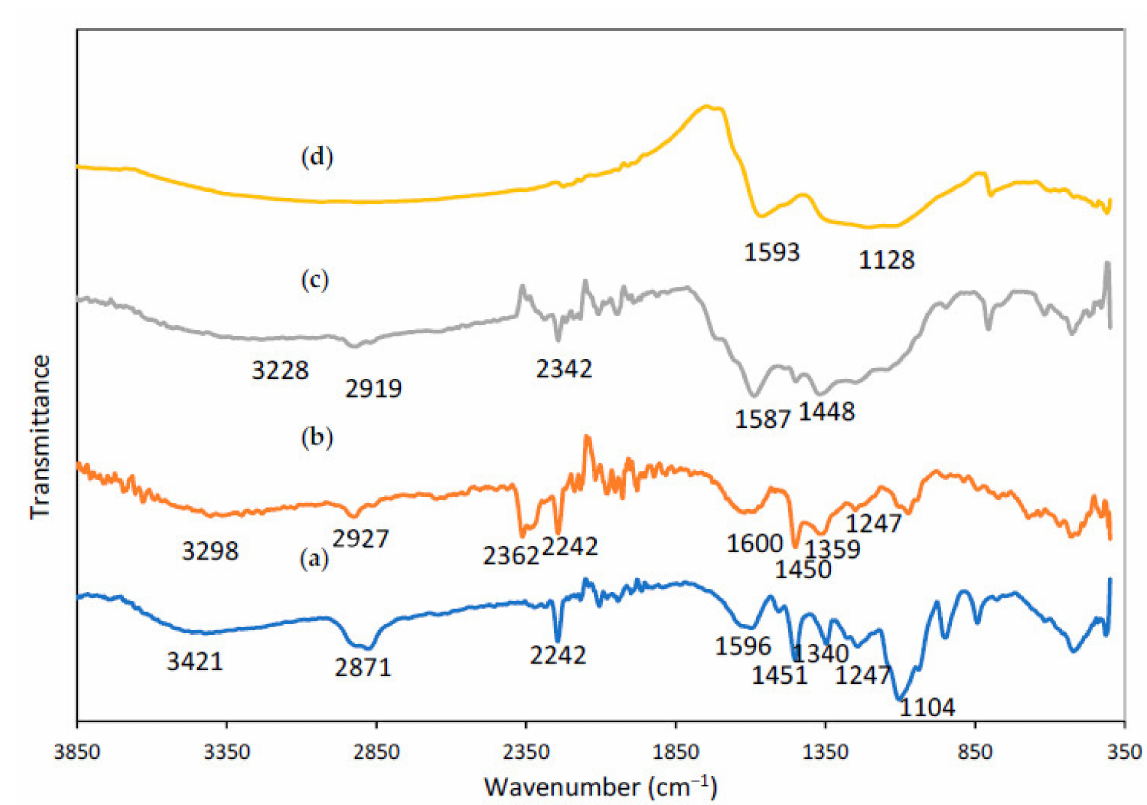
Figure 6. FTIR spectra of PAN/lignin/PEG nanofibers: ( a ) as-spun fiber, ( b ) after selective dissolution, ( c ) after stabilized, ( d )